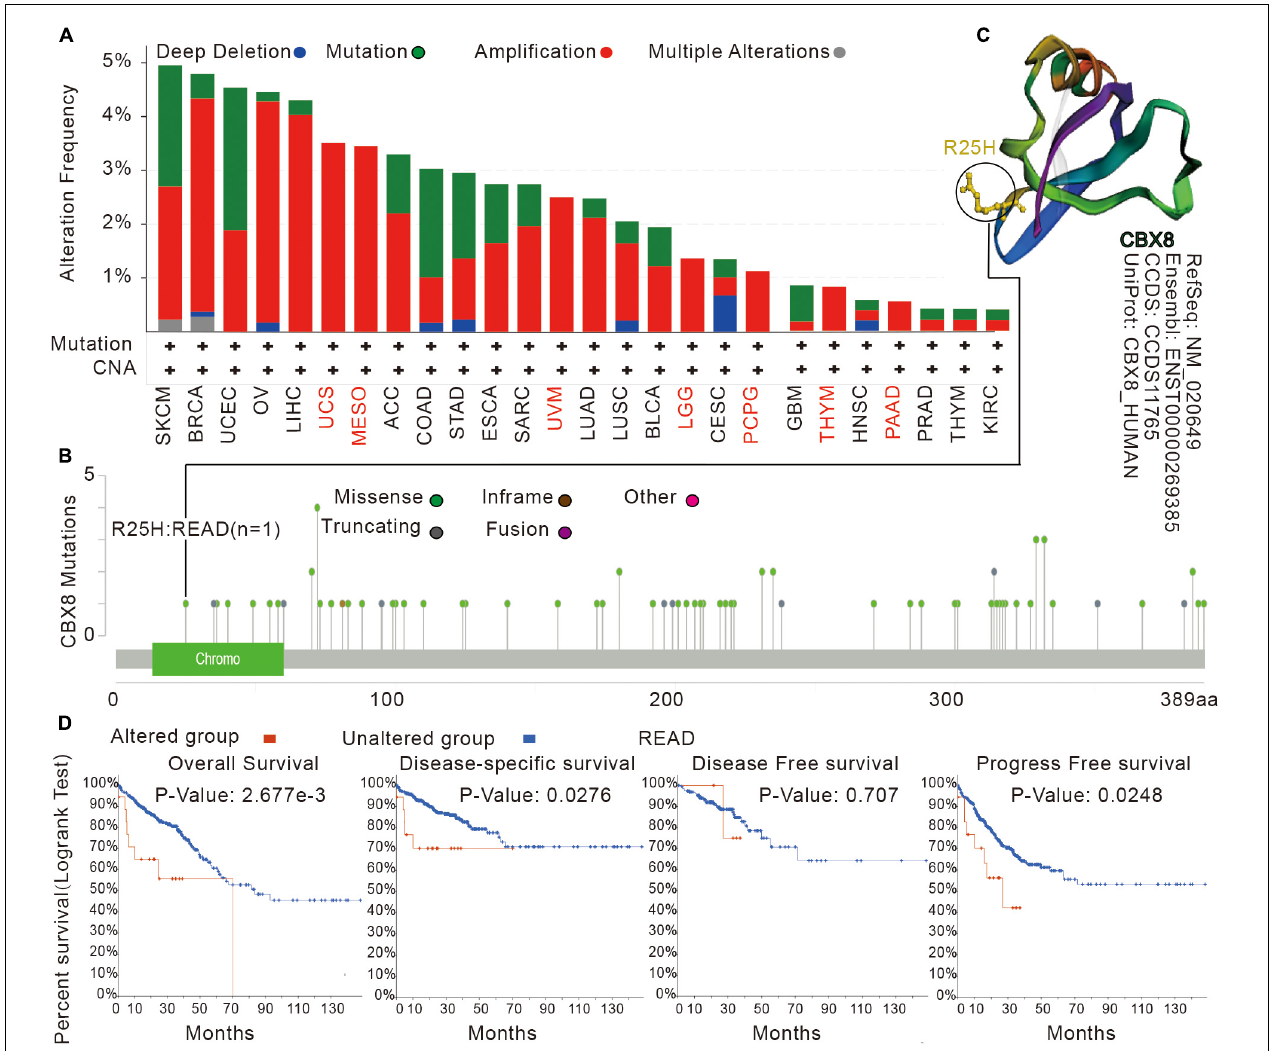
FIGURE 3 | Mutation features of CBX8 in various tumors in TCGA analyzed by the cBioPortal tool. (A) The mutation type and alteration frequency in different cancers. (B) The mutation sites in CBX8. (C) The 3D structure of CBX8 and the mutation site (R25H) in the 3D structure of CBX8. (D) The correlation between mutation status and overall, disease-specific, disease-free, and progression-free survival prognoses of READ analyzed by the cBioPortal